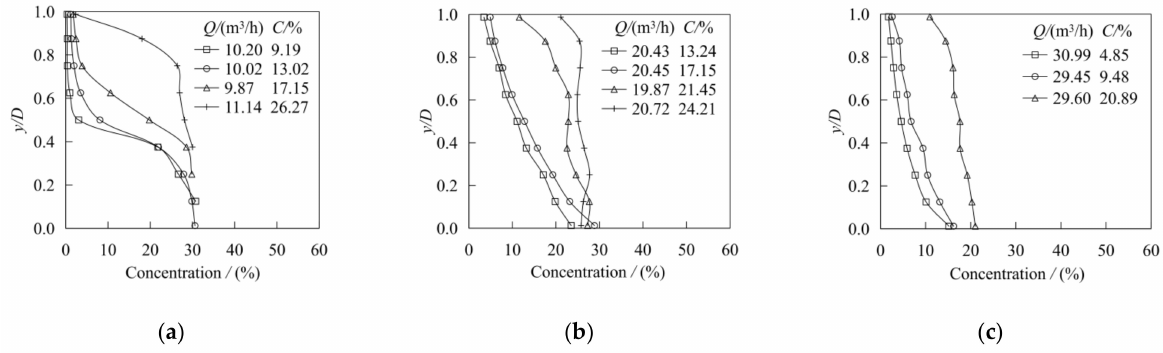
Figure 9. Vertical distribution of measured sediment concentrations in pipes for different discharges: ( a ) Q = 9.87–11.14 m 3 /h; ( b ) Q = 19.87–20.72 m 3 /h; and ( c ) Q = 29.45–30.99 m 3 /h.